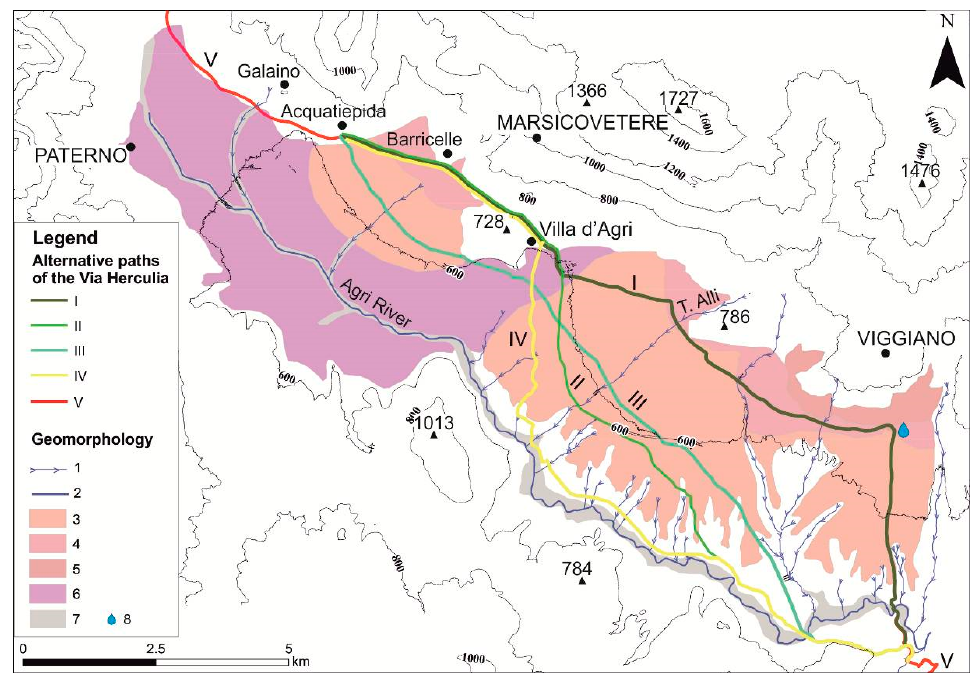
Figure 10. ( I ) First hypothesis; ( II ) second hypothesis; ( III ) third hypothesis; ( IV ) fourth hypothesis; ( V ) Via Herculia track. ( 1 ) Channel incision; ( 2 ) main river (Agri River); ( 3 ) first generation of alluvial fan; ( 4 ) second generation of alluvial fan; ( 5 ) third generation of alluvial fan; ( 6 ) fluvial deposits (first generation); ( 7 ) Late Quaternary floodplain deposits; ( 8 ) Fonte San Giovanni spring. Geological and geomorphological features are partly derived by [44].